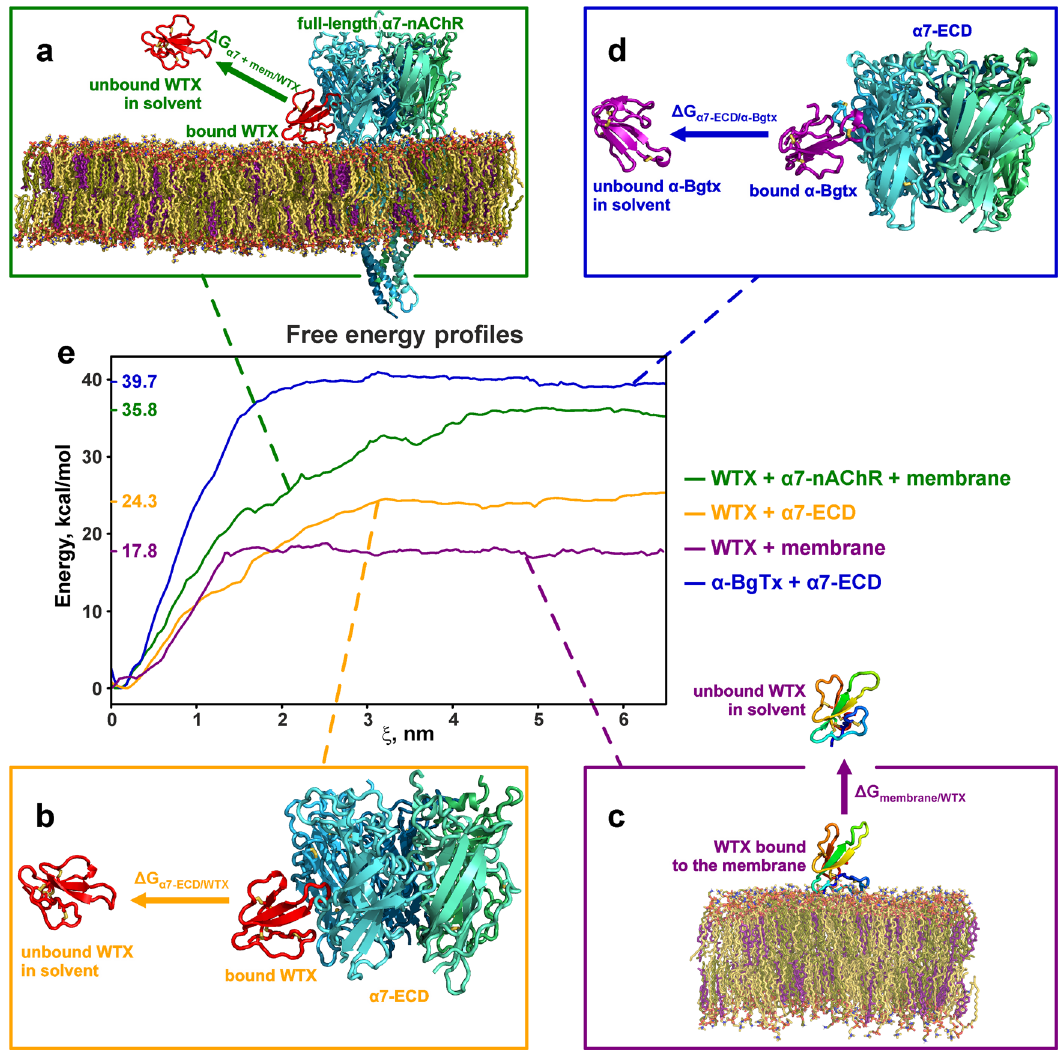
Fig. 7 Changes of the free energy ( Δ G bind ) due to the toxins binding to α 7-nAChR and/or membrane. Start and end toxin positions for calculations of the binding energies for the complexes: a α 7-nAChR/WTX in the membrane, b extracellular domain of α 7-nAChR/WTX in solution, c membrane/WTX, d extracellular domain of α 7-nAChR/ α -Bgtx in solution. e Potential of mean force (PMF) curves for the studied